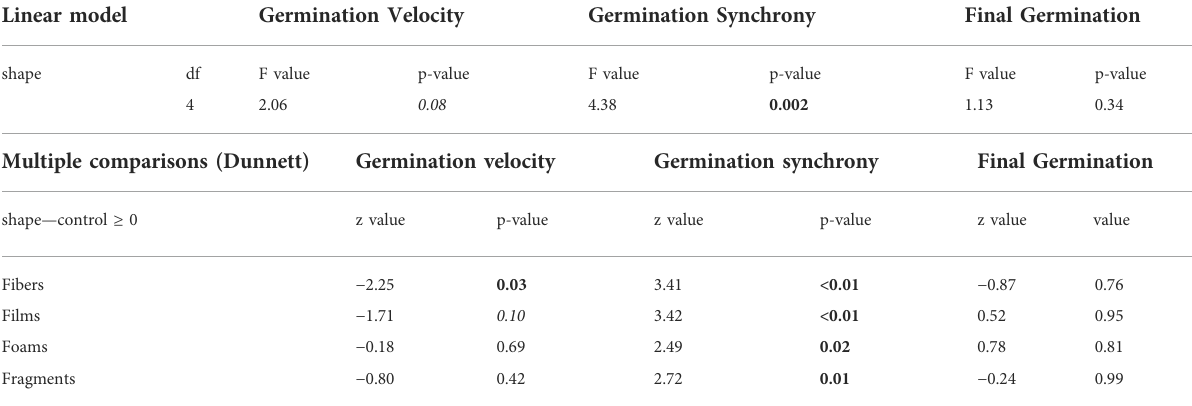
TABLE 1 Microplastic shape effects on seed germination velocity, synchrony and on fi nal germination percentage. Results of linear models and multiple comparisons by using the Dunnett test. Values in bold indicate a strong effect ( p < 0.05) and in italics a moderate effect ( p < 0.1) of microplastic shape on the dependent